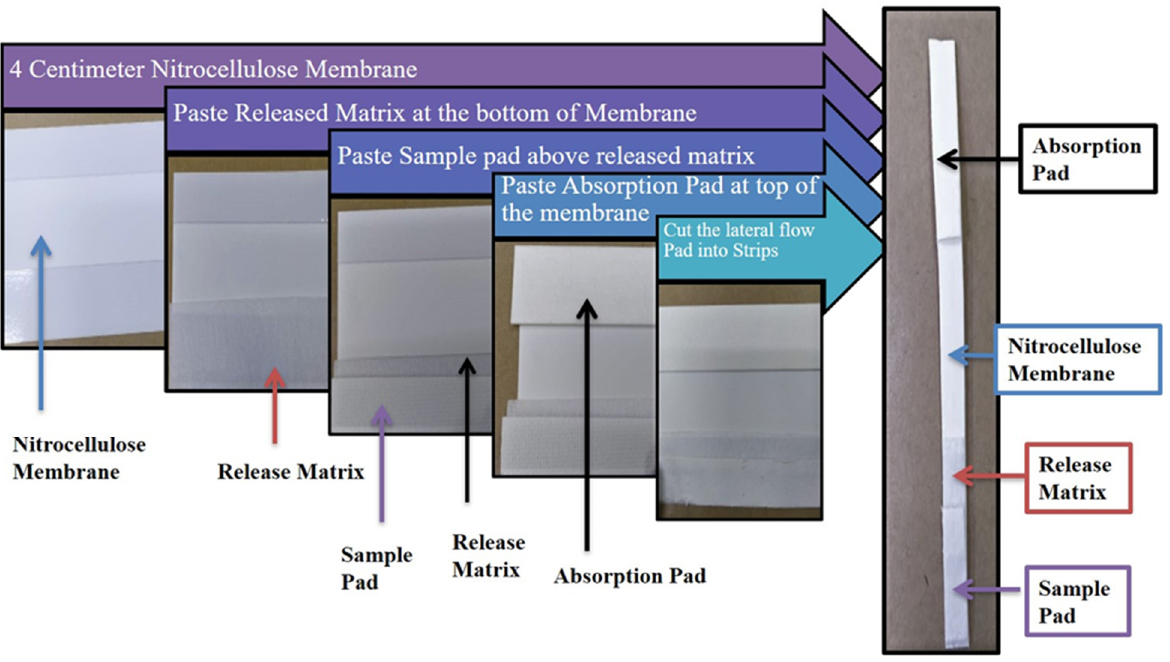
Figure 1. Assembly of membranes of Easy pack Membrane Kit components (MDI membrane technology,Gurugram, India) into lateral flow strip.